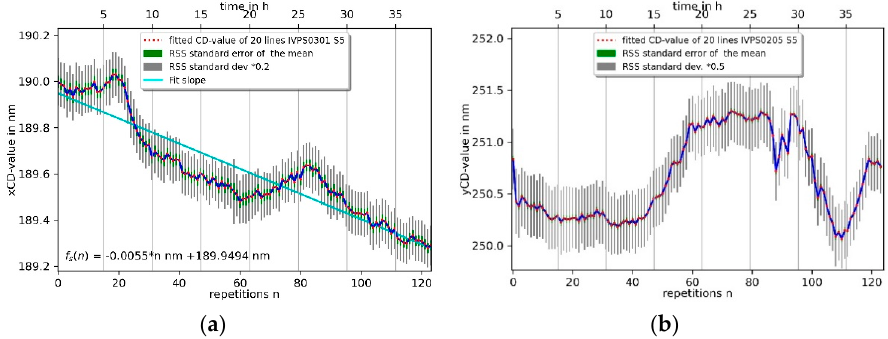
Figure 14. Stability of CD value measurement of two orthogonal mounted IVPS100-PTB structures (IVPS0301 in ( a ) and IVPS0205 in ( b )) with the 3D-Nanoprobe.